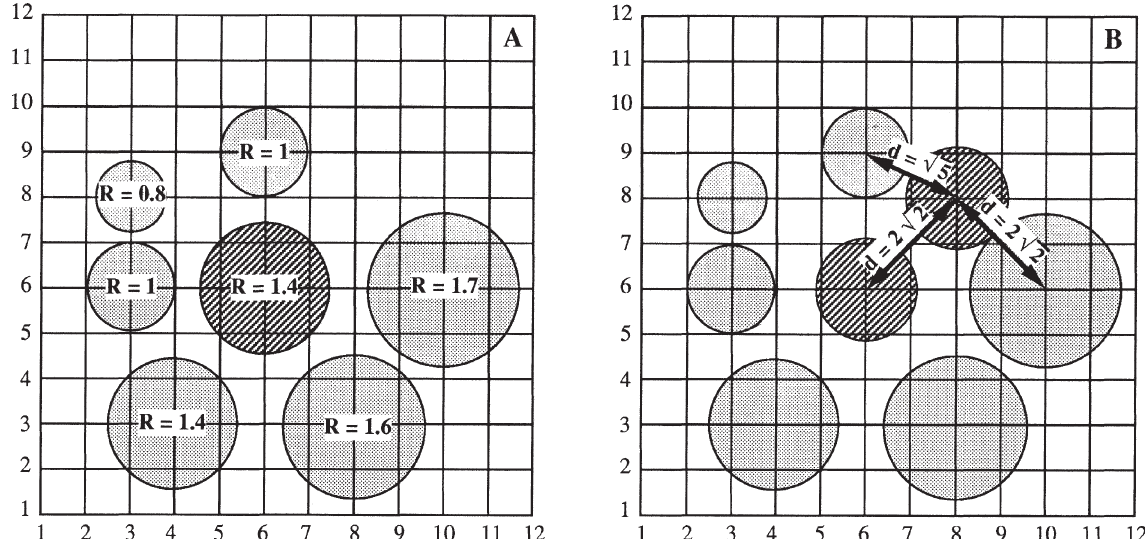
Fig. 3. Duplication process. The radius of each cell nucleus is indicated on the figure. A: The cell ( R = 1 . 4) in (6,6) is in mitosis. The radius of each daughter cell returns to 1.1. B: One daughter cell will occupy the site (6,6). The site (8,8) can be selected by the second daughter cell because the distance between this site and each occupied neighbour site is superior to the sum of the radii of this cell and each neighbour cell. Culture medium cell